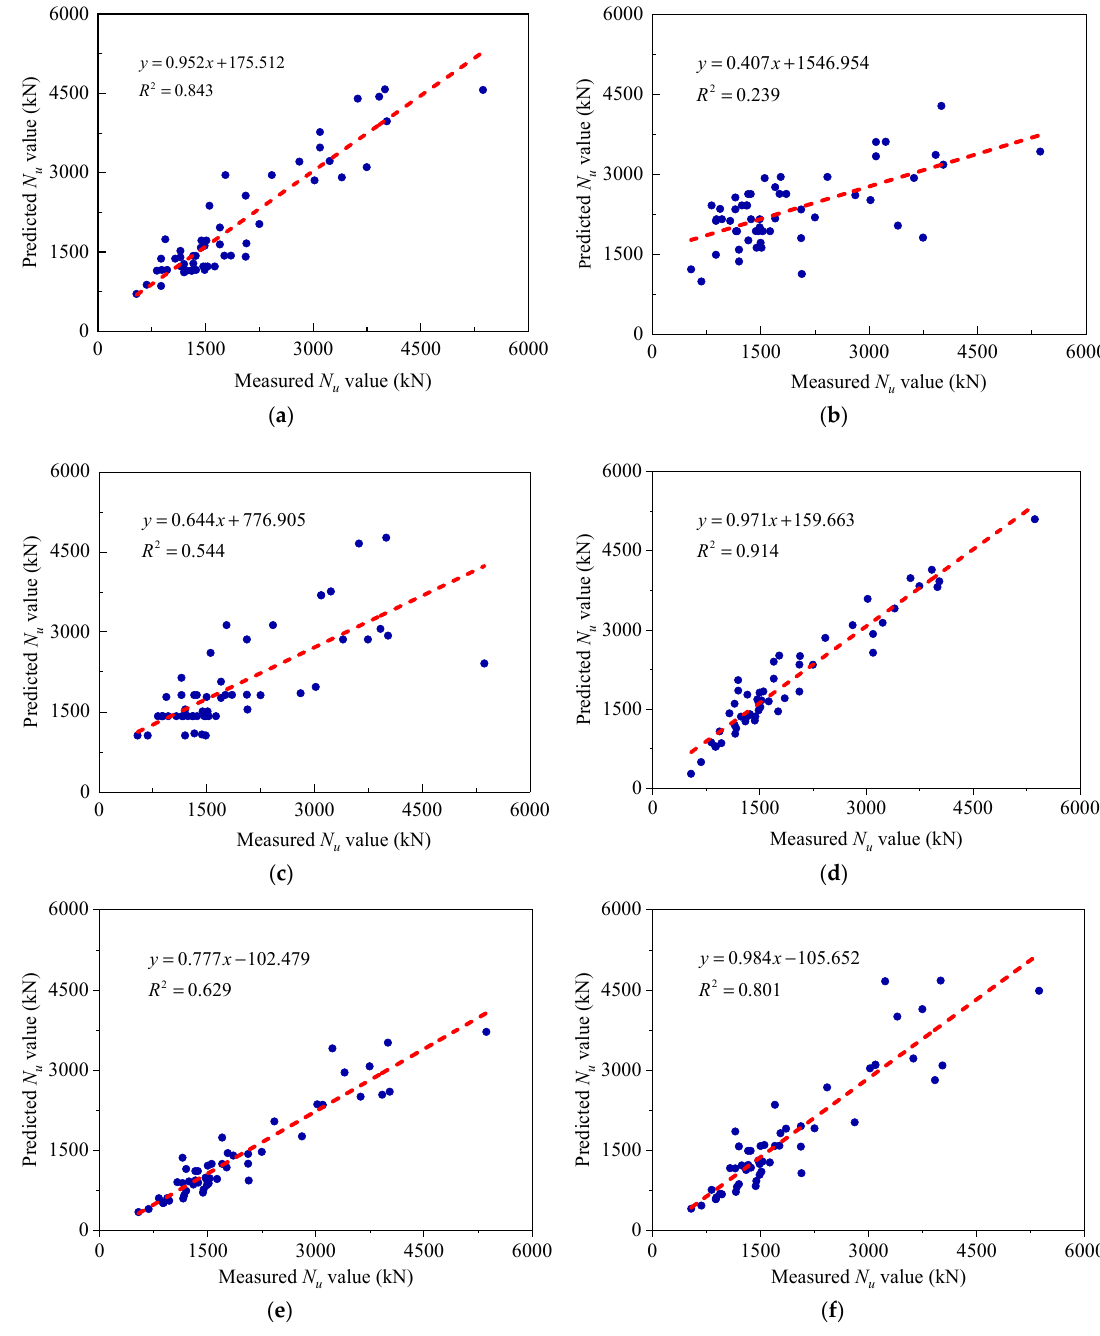
Figure 7. Coefficient of determination ( R 2 ) of the measured and predicted N u values in the test set using ( a ) decision tree (DT); ( b ) Gaussian process (GP); ( c ) multiple linear regression (MLR); ( d ) PSVM; ( e ) AIJ 1997 expression; ( f ) GJB 4142-2000 expression. Table 2. Prediction performance evaluation of DT, GP, MLR, PSVM, AIJ 1997, and GJB 4142-2000 expressions in the training set.